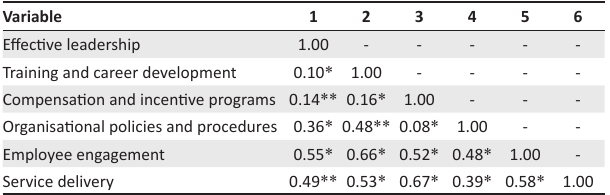
TABLE 4: Correlation analysis.